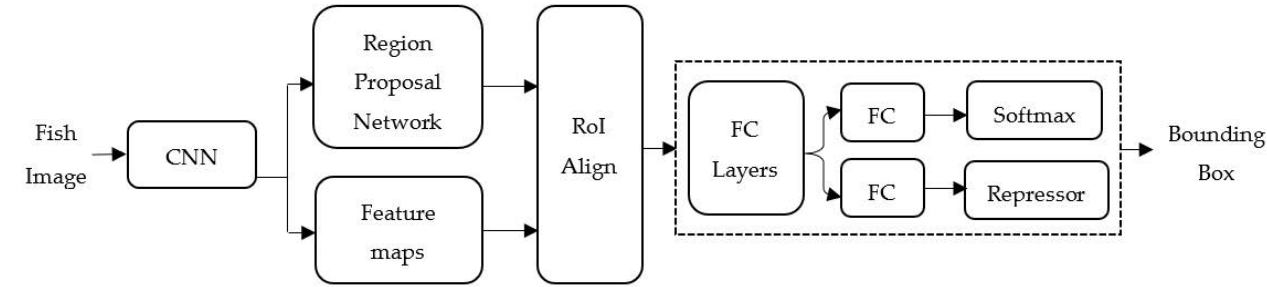
Figure 2. Mask R-CNN structure for Tilapia Detection.